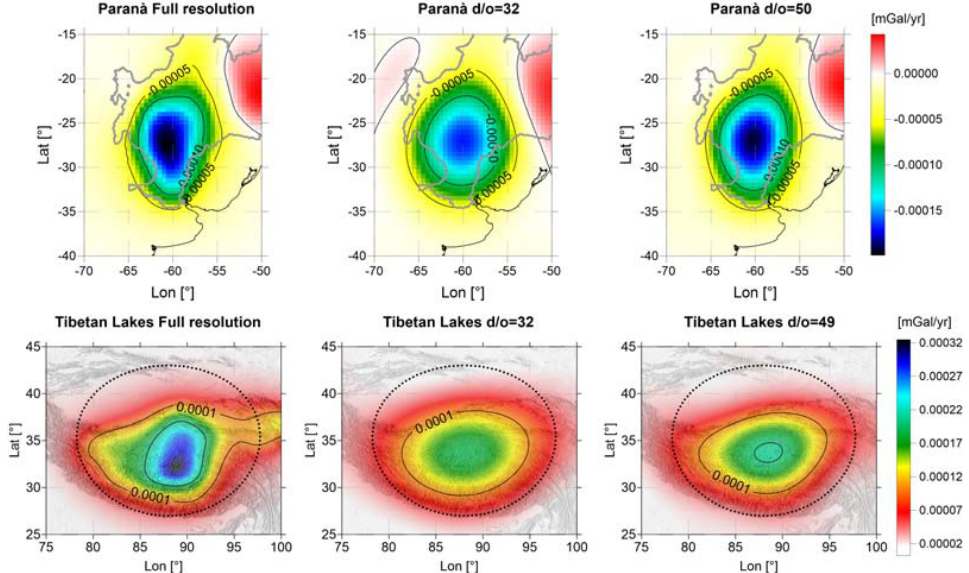
Figure 15. Comparison between the retrieved anomaly patterns for the Paraná long ‐ period hydrologic masses and the long ‐ period variation in Tibetan lakes. Left—full resolution signal; center—signal synthetized up to d/o 32, corresponding to what would be seen after 5 years by GRACE; right—signal synthetized up to d/o 49, corresponding to what would be seen after 5 years by MOCAST+. Fields calculated at 250 km altitude.